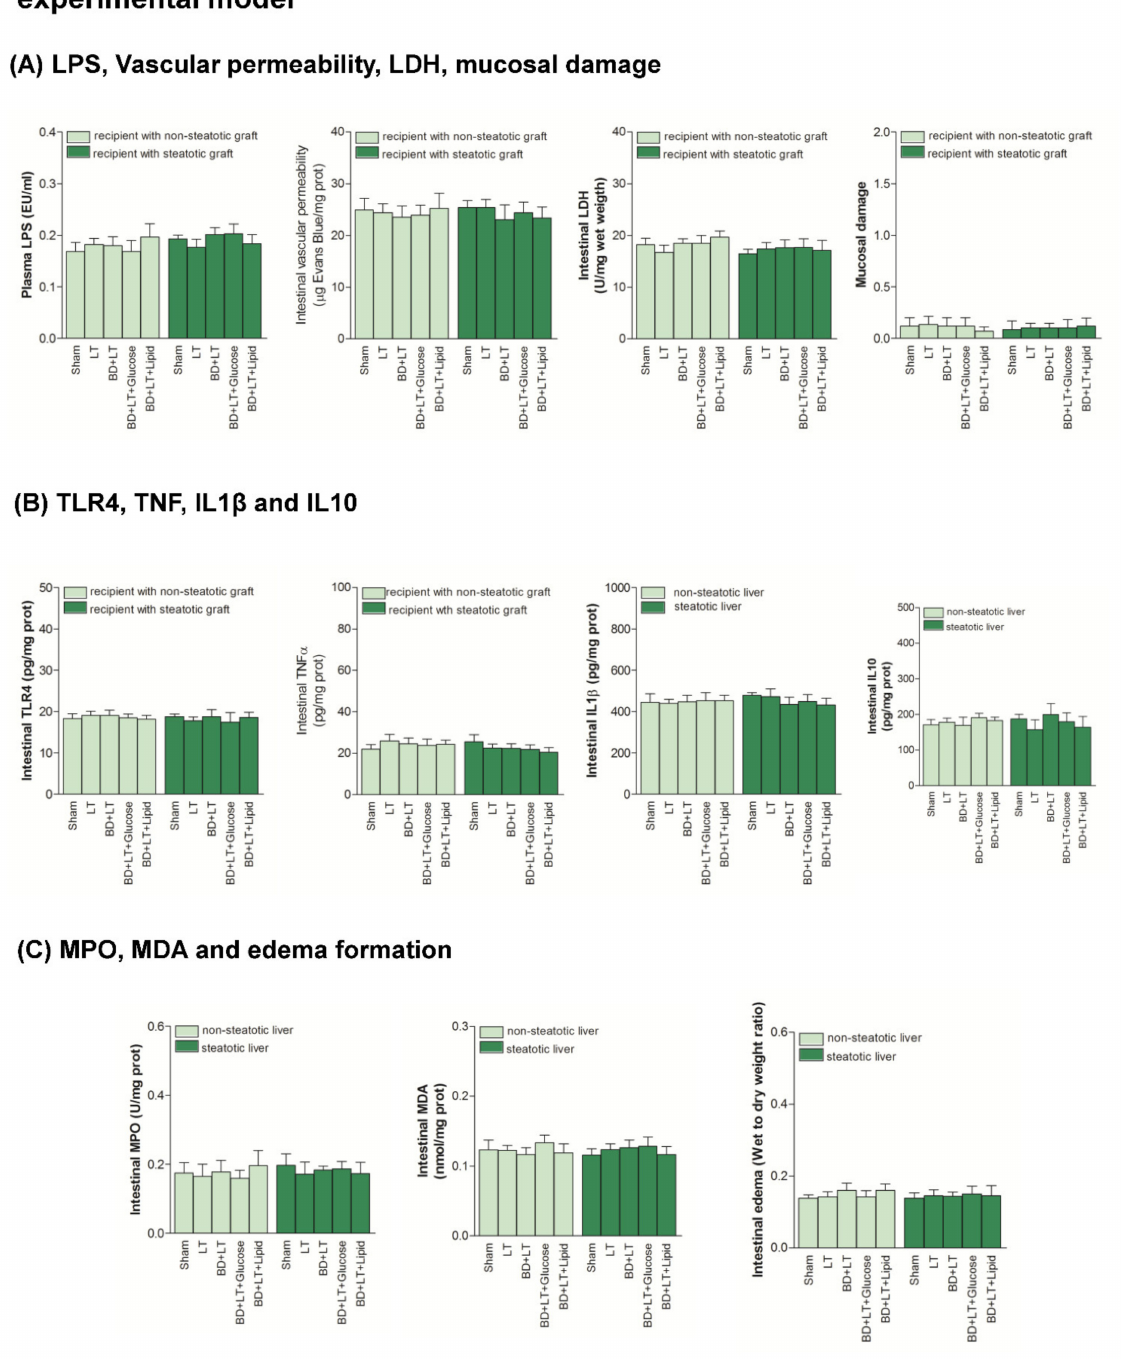
Figure 4. Effects of glucose and lipids on intestinal inflammation and damage in steatotic and non-steatotic LT in a genetic obesity experimental model. ( A ) LPS in plasma, and vascular permeability, LDH and mucosal damage in intestine. ( B ) Toll like Receptor 4 (TLR4), Tumor necrosis factor (TNF), Interleukin (IL)1 β and Interleukin (IL)10 in intestine. ( C ) Myeloperoxi- dase (MPO), Malondialdehyde (MDA) and edema formation in intestine. Sham vs. Liver Transplantation (LT) or Brain Death+Liver Transplantation (BD + LT), p = not significant; LT vs. Brain Death+Liver Transplantation (BD + LT), p = not significant. DBD, Donors after Brain